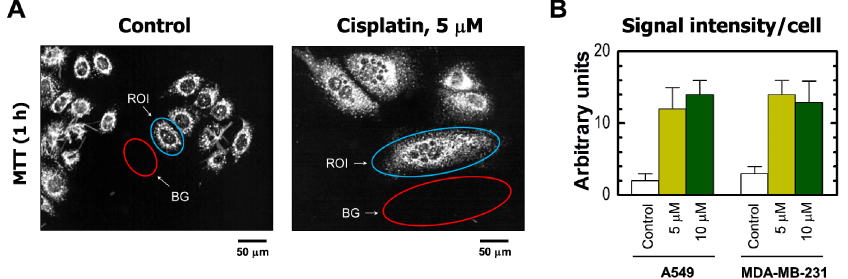
Figure 3. ( A ) Representative images of MDA–MB-231 cells used for image analysis. The images of MTT metabolites were acquired as described in Figure 2 legend (upper row). The images were then converted to grayscale and inverted. Blue and red ovals mark some regions of interest (reflecting MTT metabolites) and corresponding background regions used for image analysis, respectively; ( B ) densitometric evaluation of MTT metabolic activity for the indicated cultures, expressed as signal intensity for regions of interest (cells) after corresponding background corrections. Mean values for at least 30 cells are presented for each sample. Bars, SE. ROI, region of interest; BG, background.